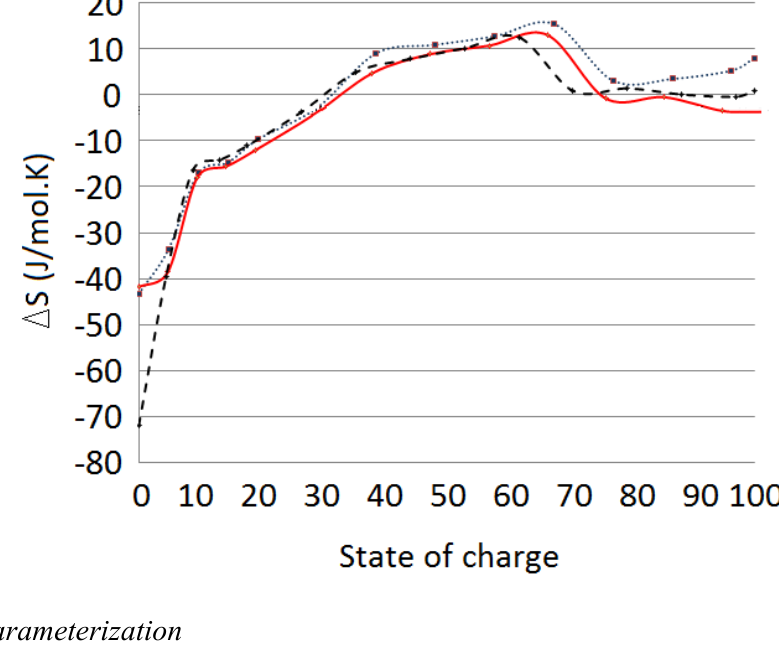
Figure 4. Discharge entropy change calculated using Equation (12) across state of charge ( SOC ) range for a 20-A·h LiFePO (solid line) and a 20-A·h LiMn